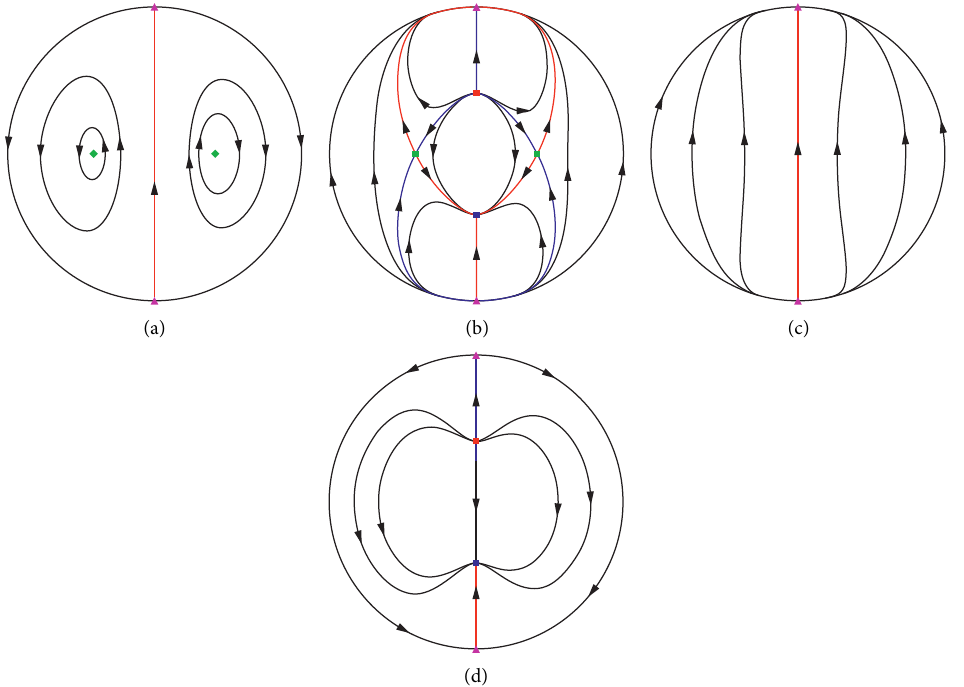
Figure 11: Trajectories in the global phase portraits of system (27). (a) Trajectories in the global phase portraits of system (27) for b > 0 and c > 0. (b) Trajectories in the global phase portraits of system (27) for b < 0 and c < 0. (c) Trajectories in the global phase portraits of system (27) for b < 0 and c > 0. (d) Trajectories in the global phase portraits of system (27) for b > 0 and c <